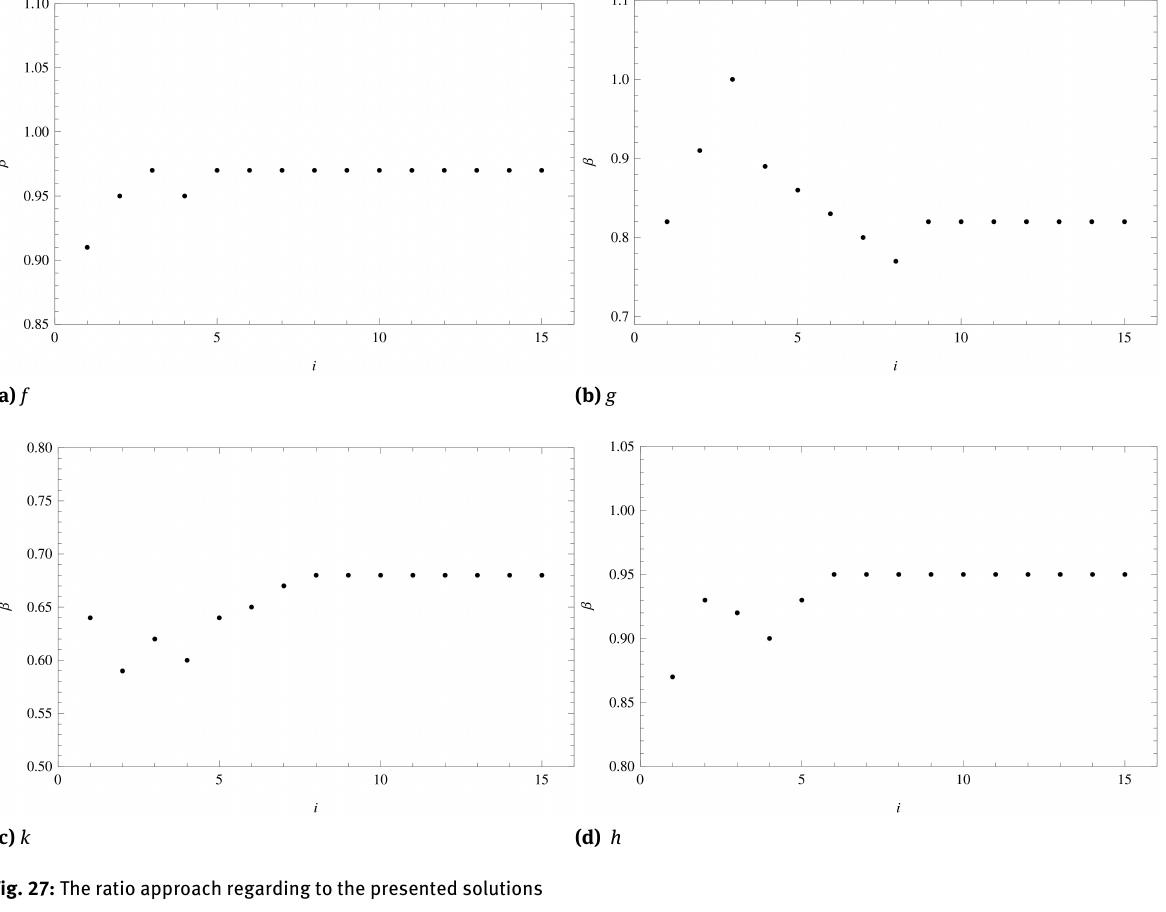
ious parameters have been investigated on flow by plot- tinggraphs.Numericalvaluesofvariousvelocityfunctions have been computed and compared results with Wang [9]. The outcomes of the study can be explained as: